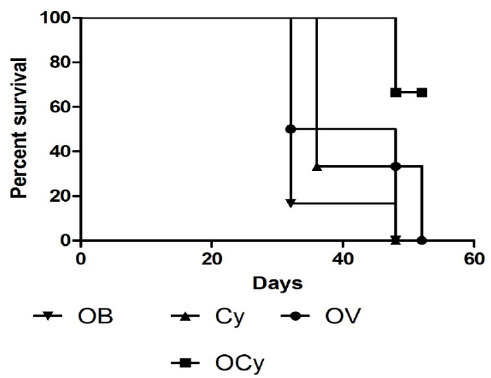
Figure 7. Kaplan–Meier survival curve for animals receiving the following treatments: blank